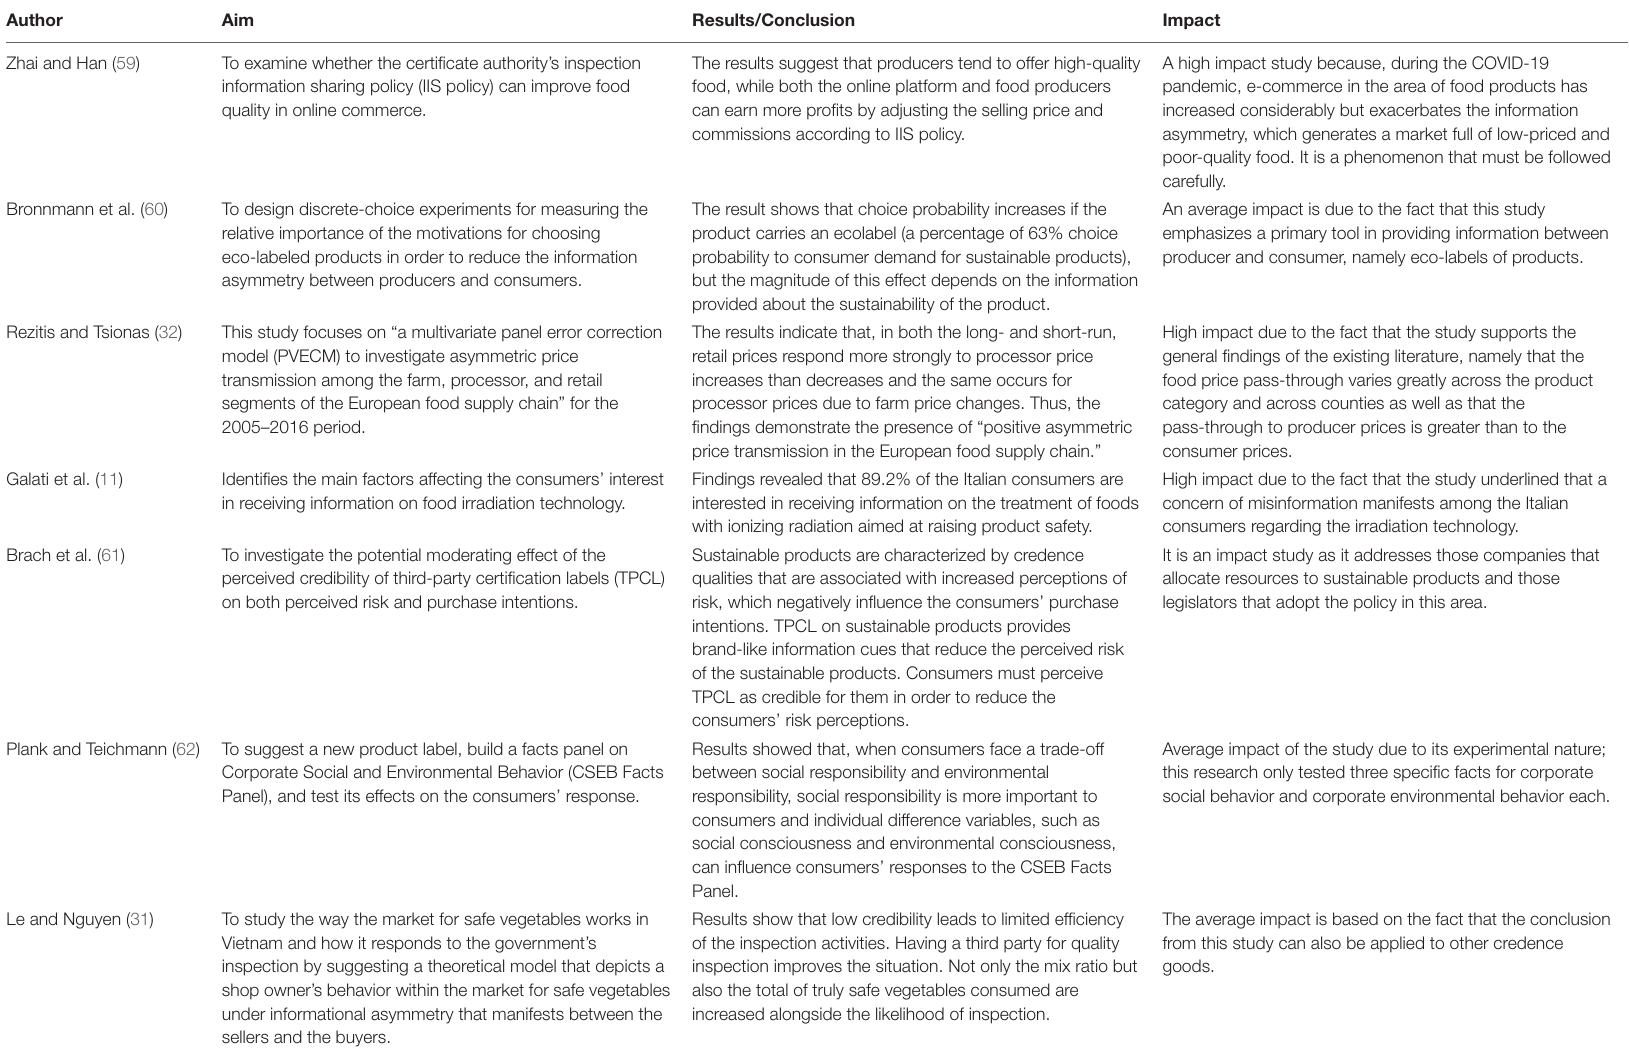
TABLE 1 | The synthesis of the main impact studies on the researched